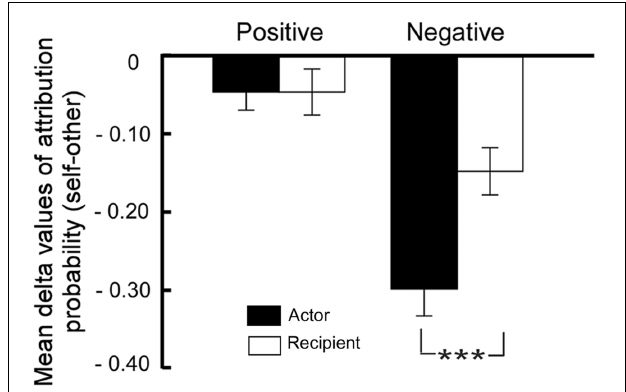
FIGURE 1 | Mean delta values (self–other) when the self was an actor or a recipient in positive and in negative interpersonal events ( ∗∗∗ p < 0.001; error bars indicate standard error of the